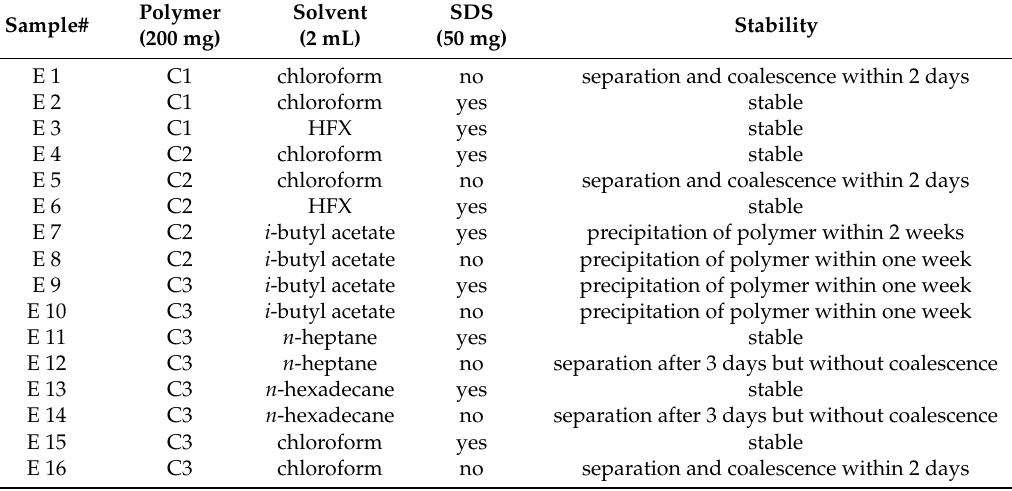
Table 3. Emulsions of terpolymers in 20 mL water at room temperature after sonication for 10